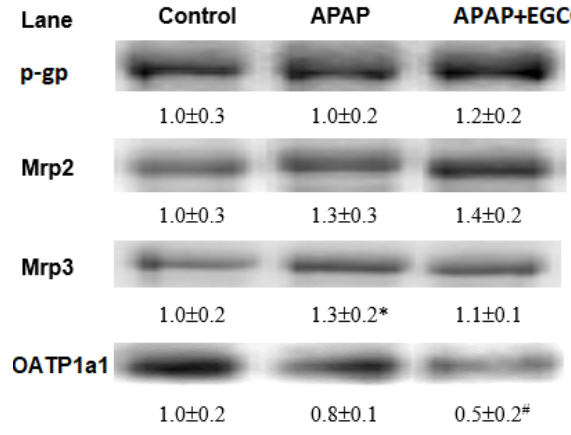
Figure 4. Densitometry quantitation of Mrp2 / 3, p-gp, and OATP1a1 protein expression from